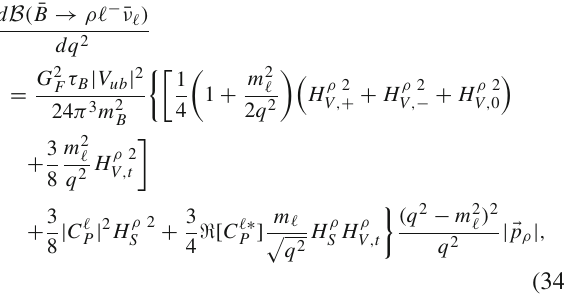
μ | – | C τ | plane from R τ μ for different values of P P μ and φ τ are P P